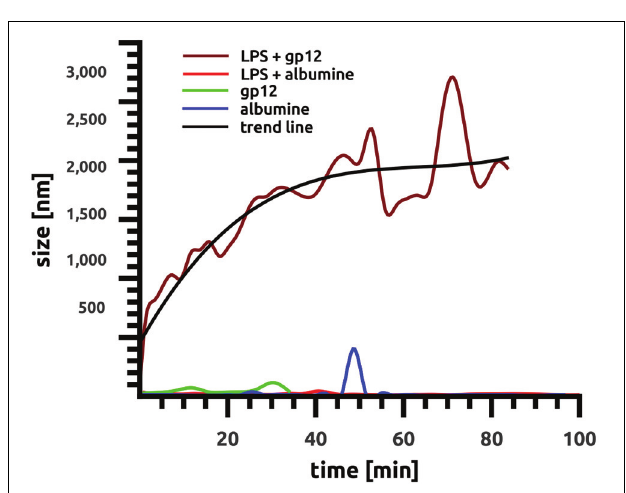
FIGURE 2 | Binding of gp12 to lipopolysaccharide in vitro over time. Binding was identified as changes in average particle size in solution by the dynamic light scattering (DLS) method using Malvern Zetasizer NanoZS (Malvern Instruments, UK). All samples were diluted with deionized water, and size distribution was measured at 25 ◦